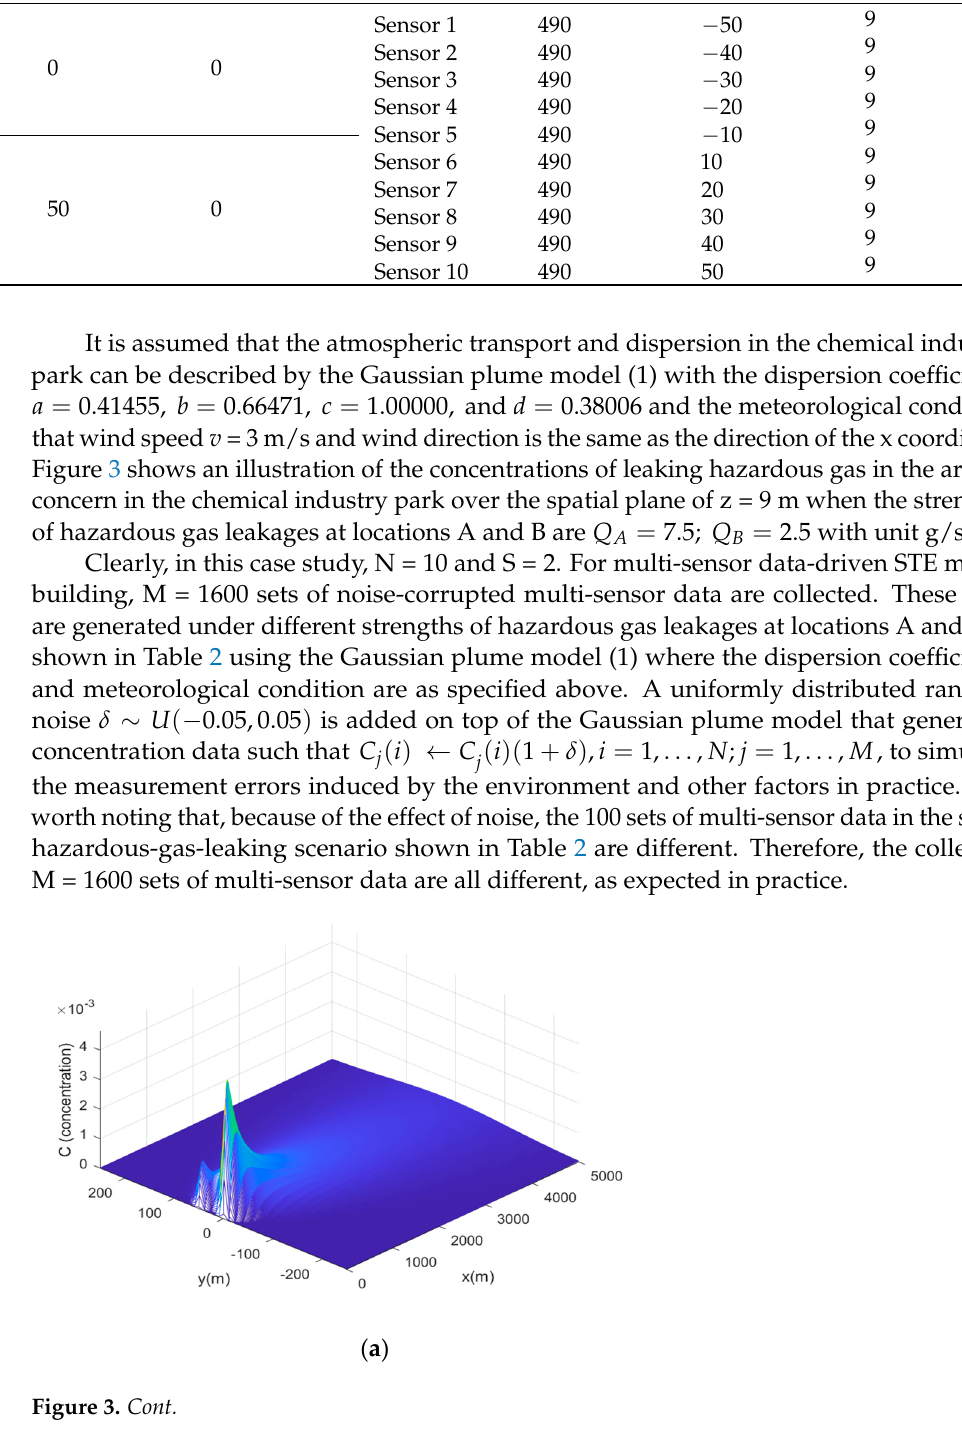
Table 1. The location of hazardous-gas-leaking sources and monitoring sensors.